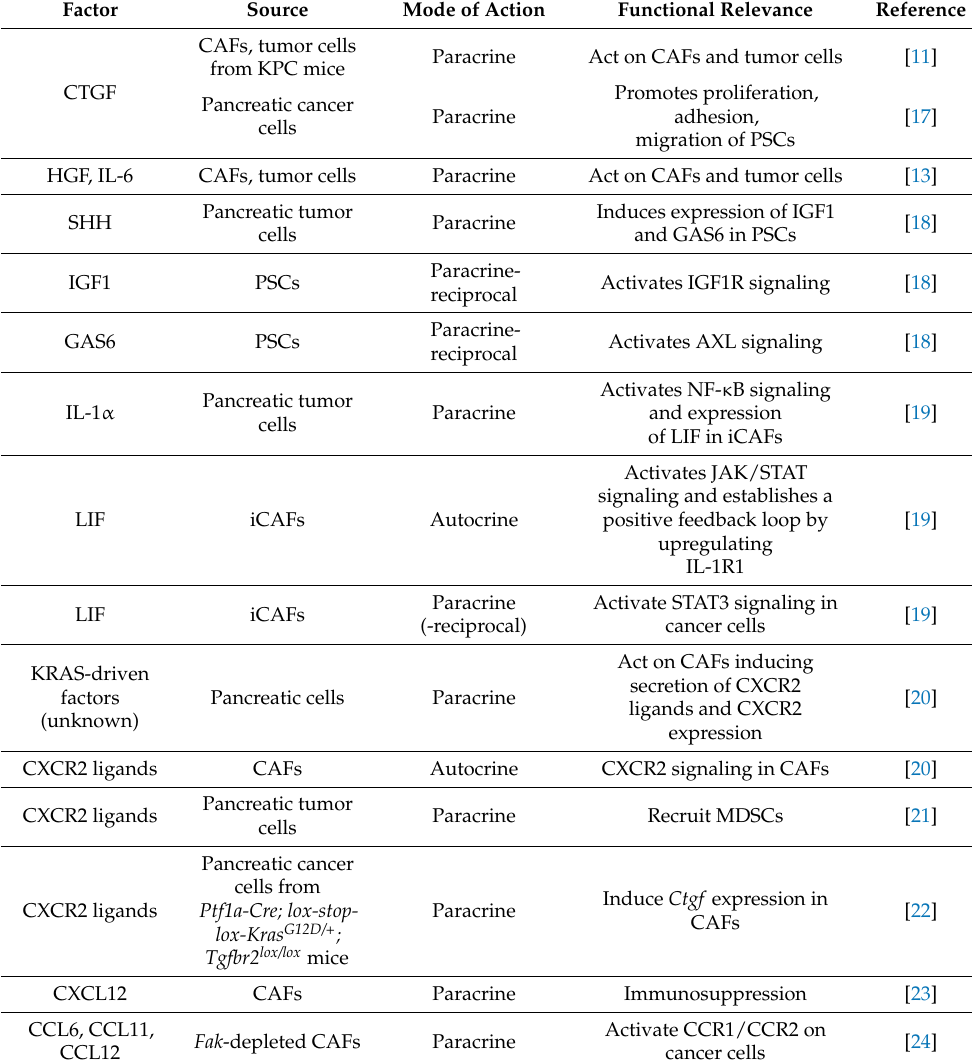
Table 1. Overview of autocrine, paracrine, and paracrine-reciprocal factors secreted from cancer- associated fibroblasts and tumor